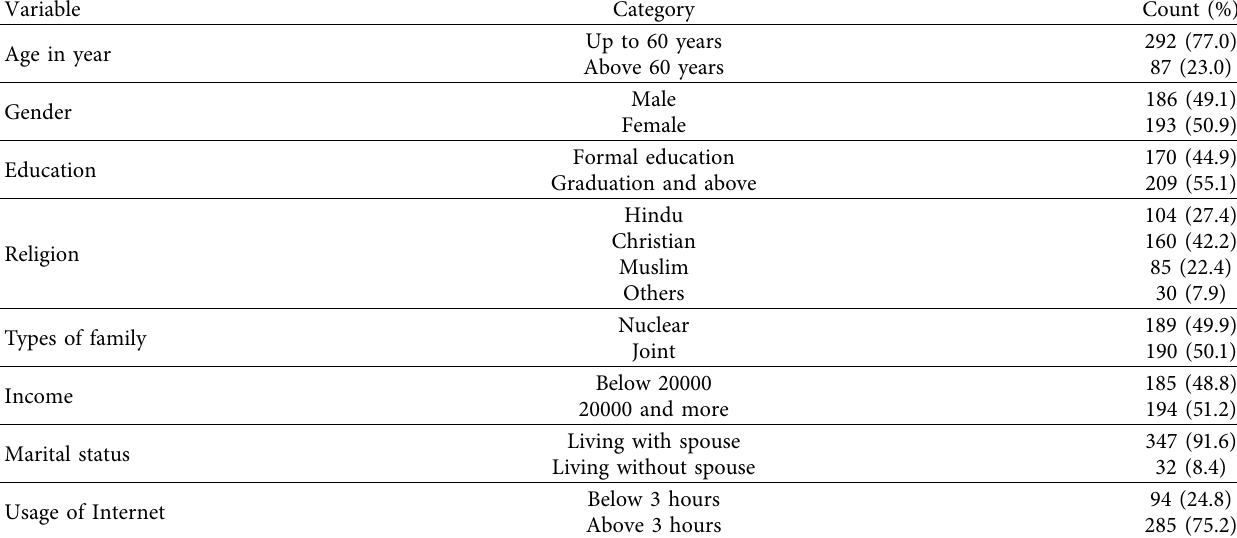
Table 1: Distribution of sociodemographic characteristics of the participants.